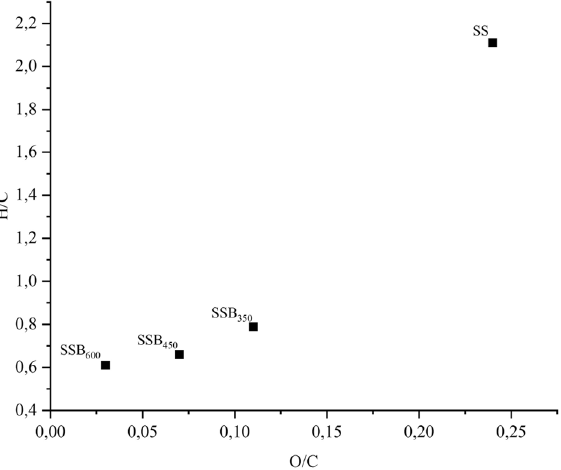
Figure 2. van Krevelen diagram for sewage sludge (SS) and sewage sludge biochar (SSB) produced at the pyrolysis temperatures of 350 (SSB 350 ), 450 (SSB 450 ) and 600 (SSB 600 ).